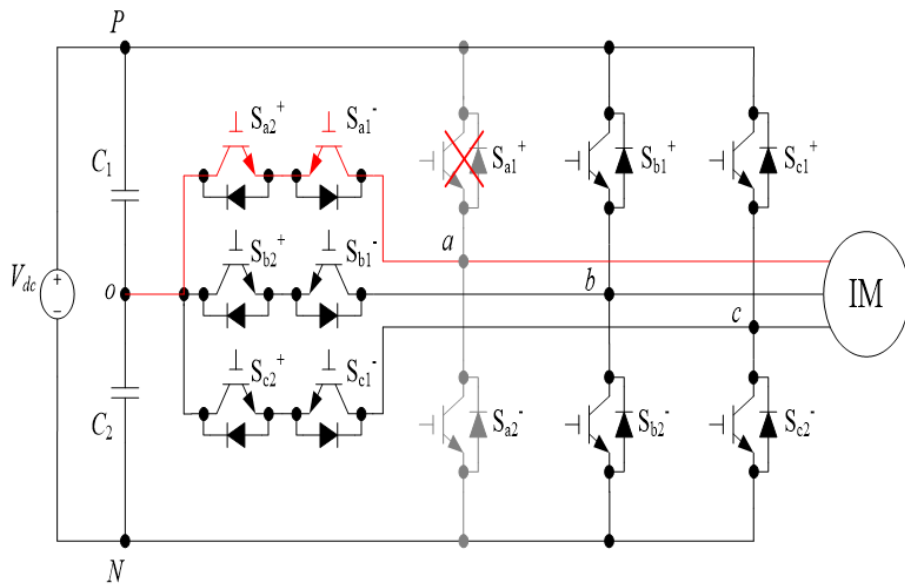
Figure 13. FTC for the occurrence of an open-circuit fault in S a 1 + .